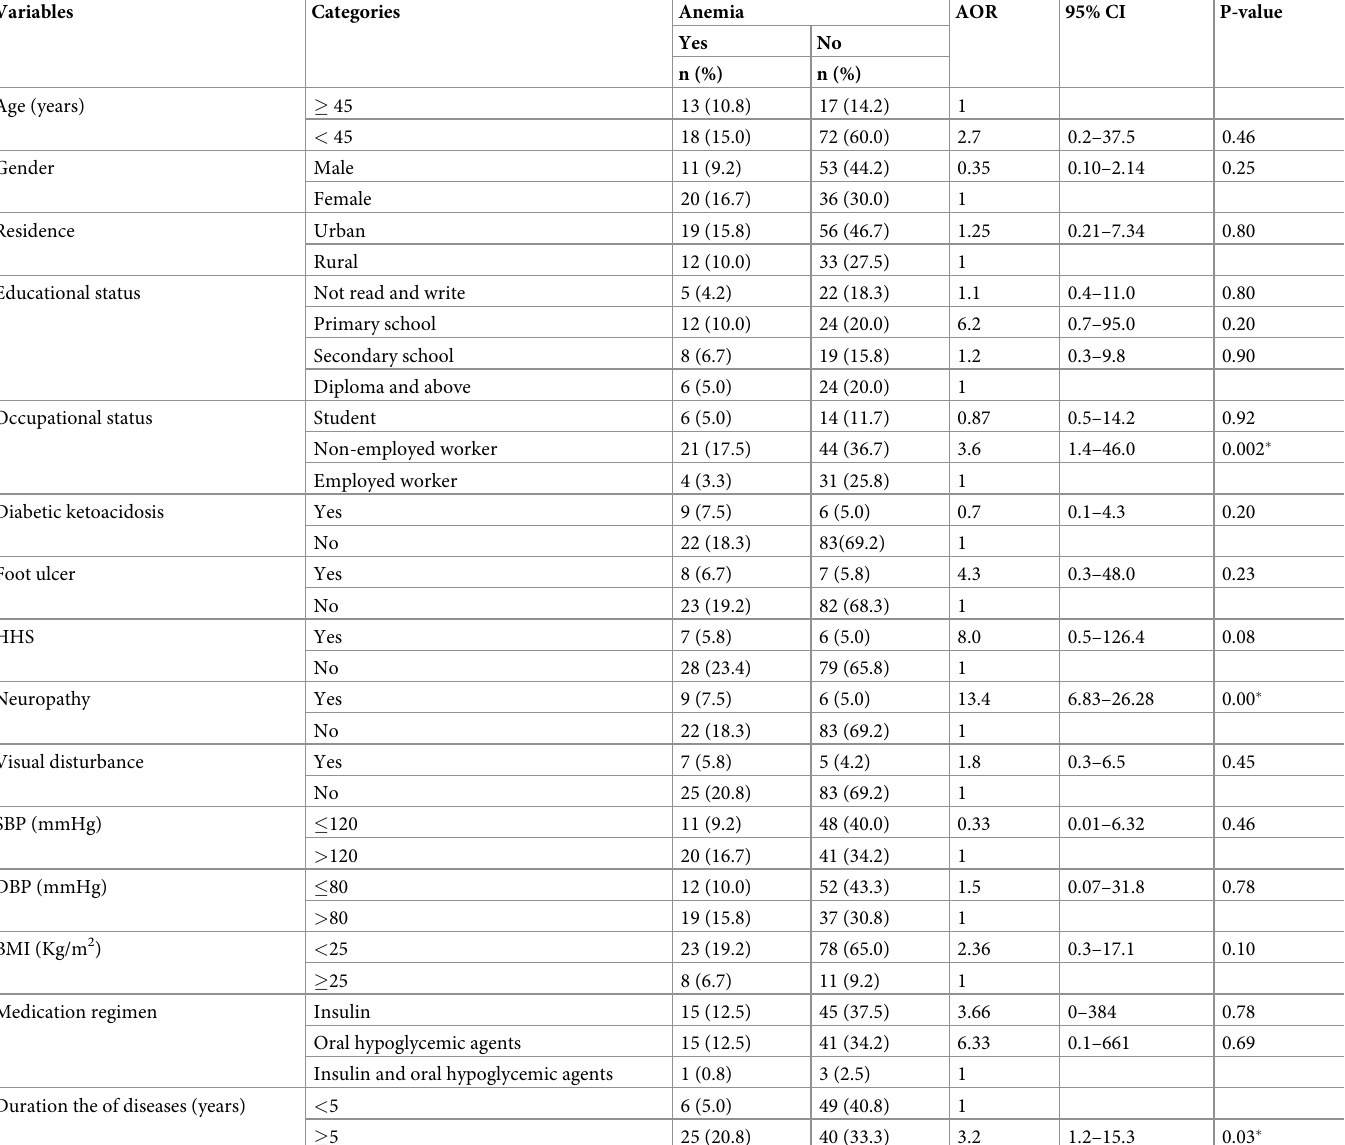
Table 5. Association of socio-demographic and clinical variables with anemia among T2DM patients at Dessie comprehensive specialized hospital, Northeast Ethio- pia from January to June 2021 (n = 120). Variables